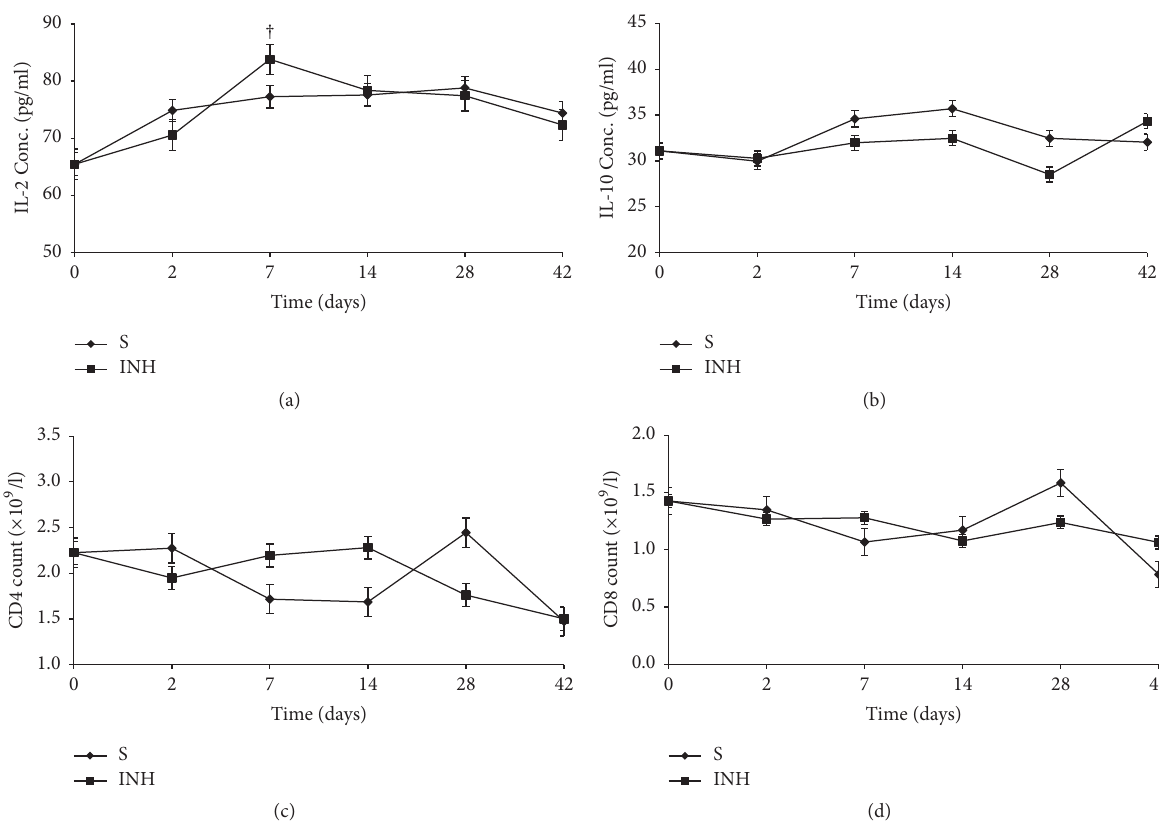
Figure 7: Serum concentrations (mean ± sd) of IL-2 (a), IL-10 (b), and CD4 (c) and CD8 (d) count during treatment with isoniazid (INH) and saline (S). Note: † = 𝑝 ≤ 0.05